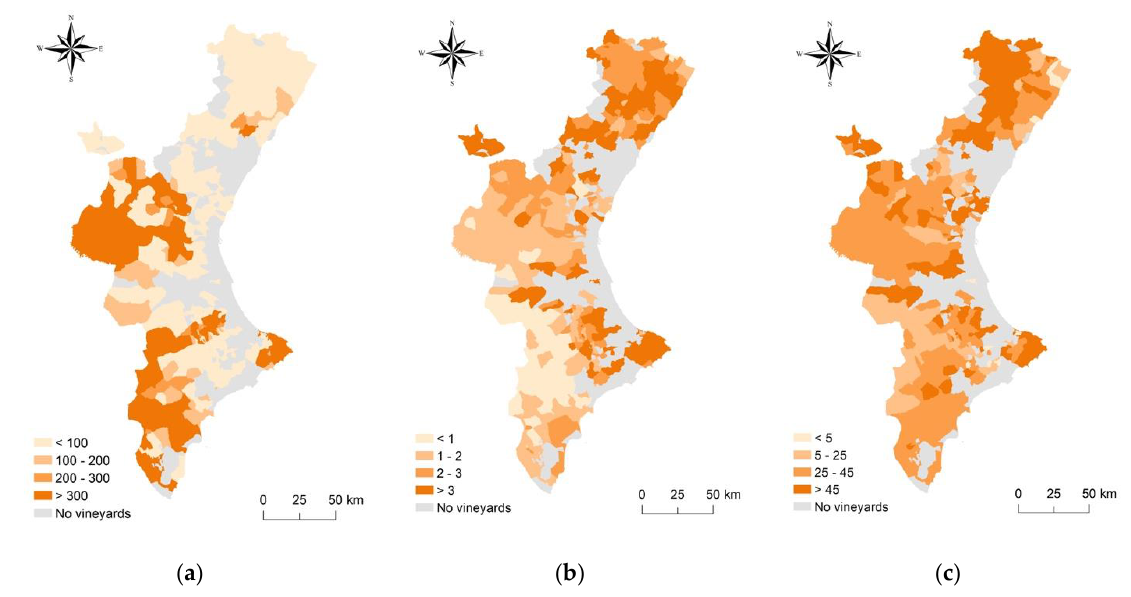
Figure 2. Number of wine parcels in each municipality of Valencian community ( a ); density of wine parcels ( b ); and average age of wine parcels per municipality ( c parcels ( b ); and average age of wine parcels per municipality ( c ).